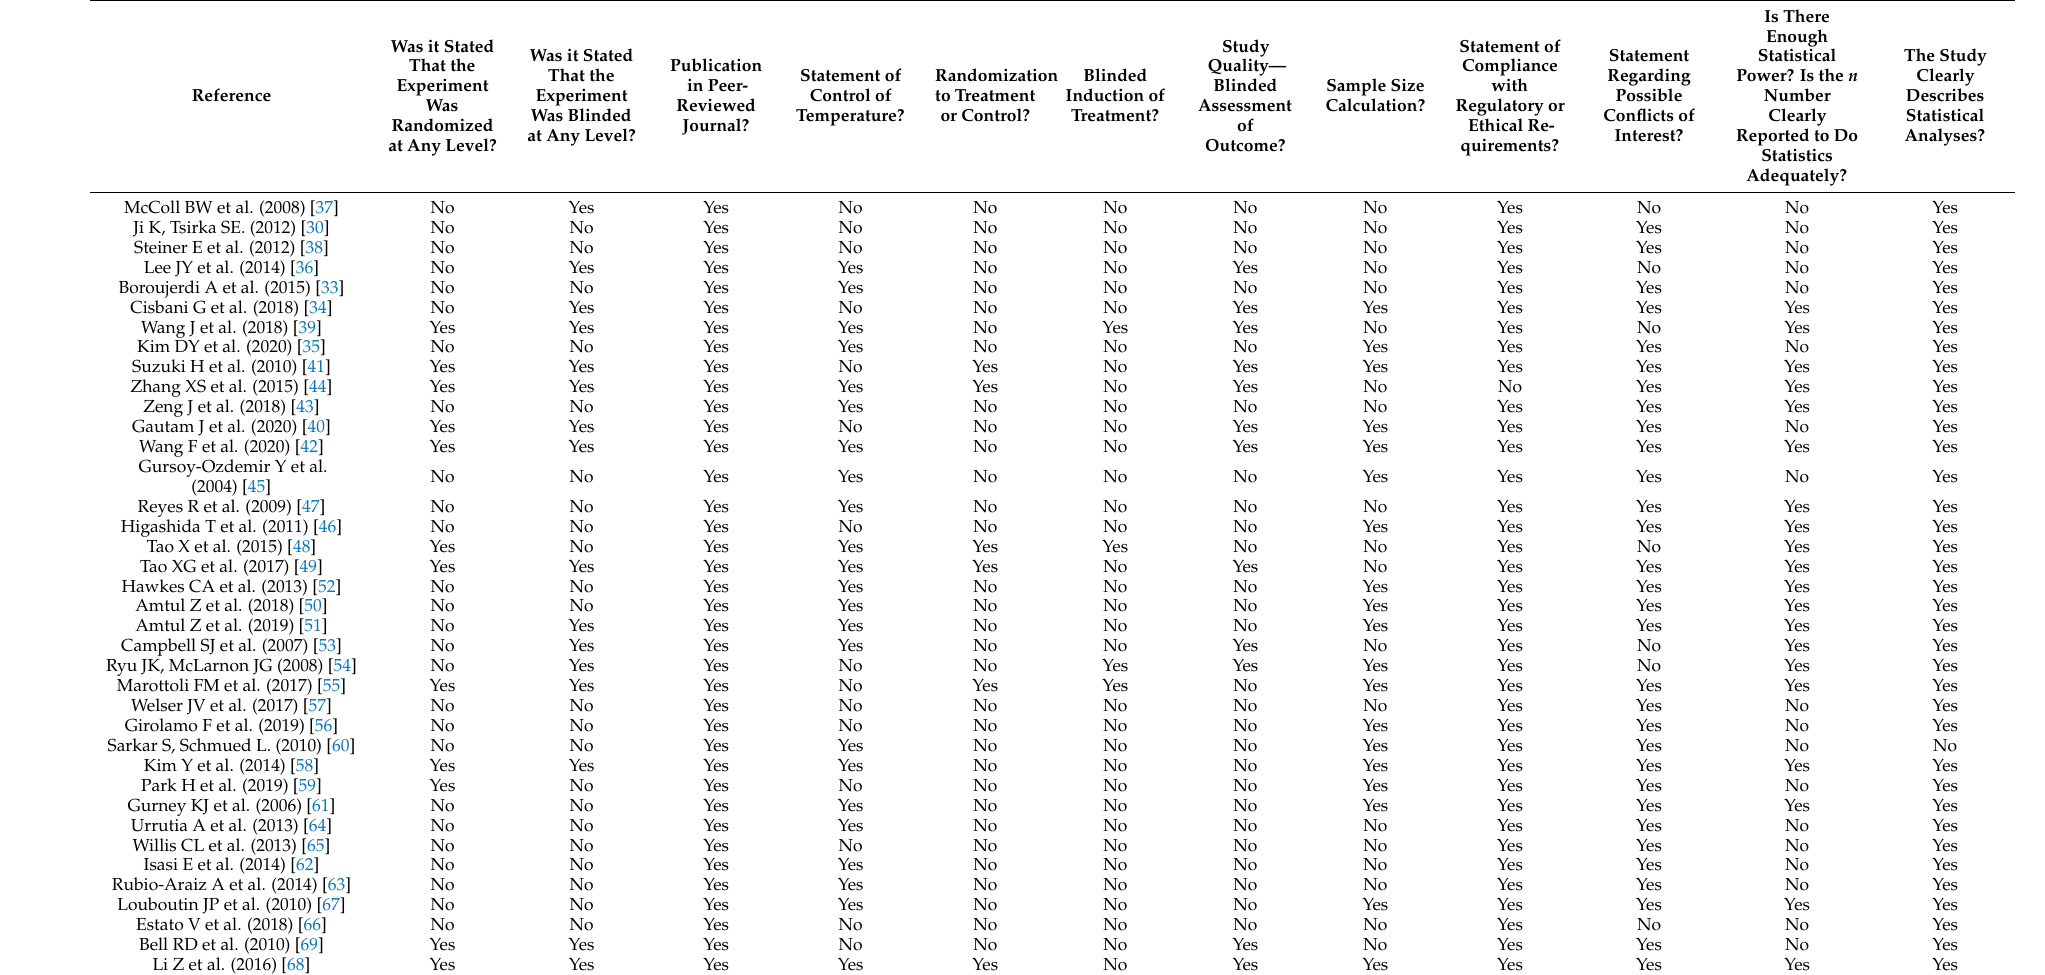
Table 3. Study quality